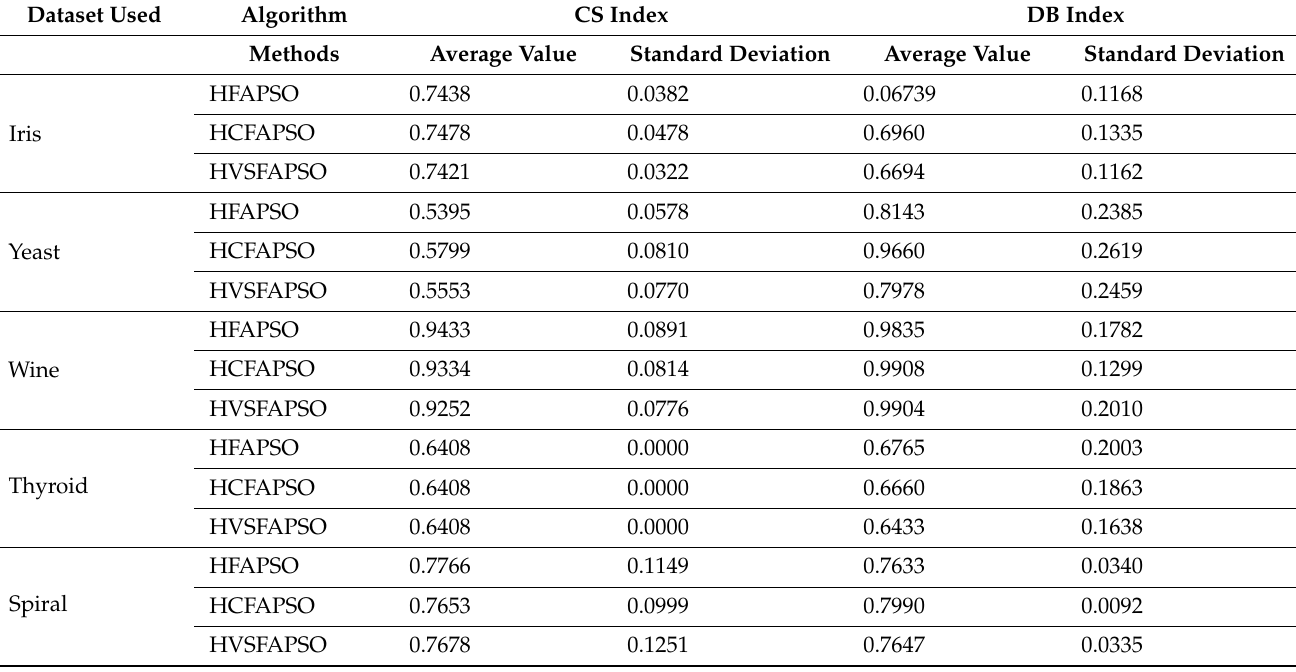
Table 6. Result Comparison of HFAPSO, HCFAPSO and HVSFAPSO for Automatic